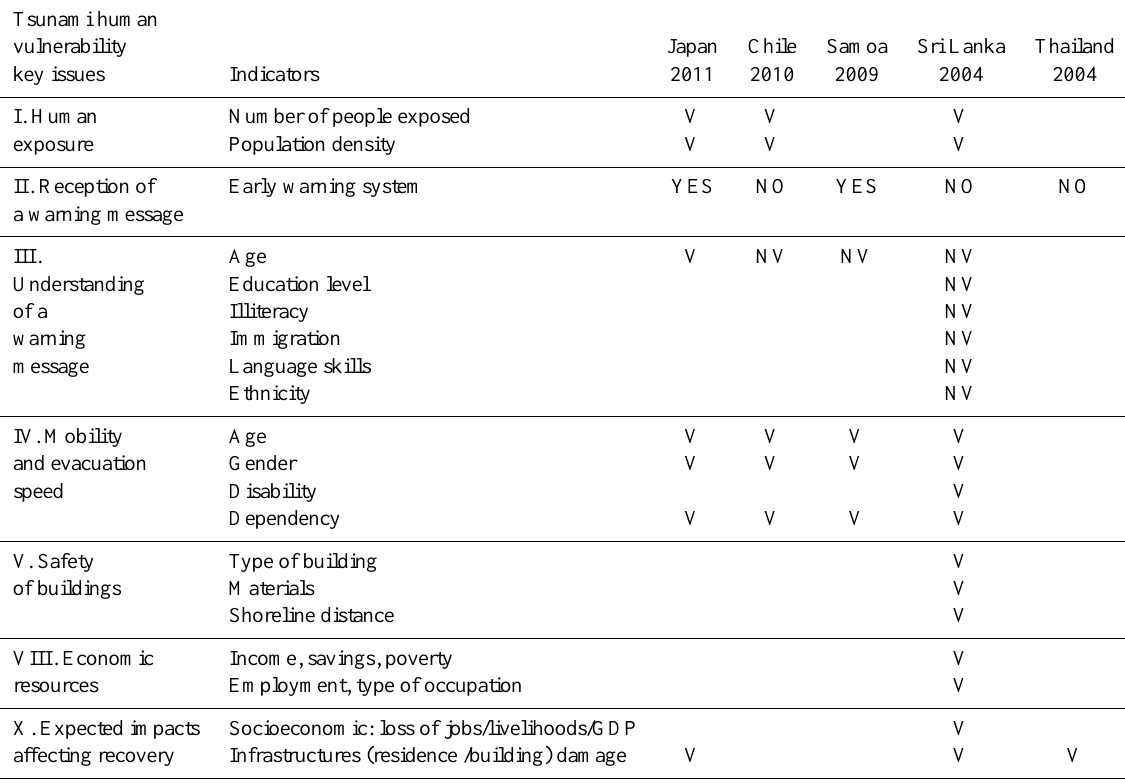
Table 3. Indicators validated in this paper based on available information; V: indicators validated, NV: indicators not validated although the information is available, since the countries did not issue a tsunami warning before the first wave reached the